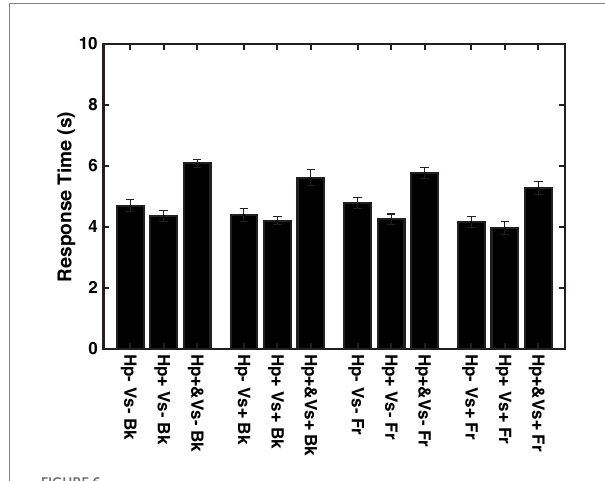
FIGURE 6 Response times for individual conditions. Vs +: visual cue present with binocular stereopsis. Vs -: visual cue absent with monocular presentation. Hp+&: haptic cue with visual presentation. Hp+: haptic cue subsequently to visual presentation. Hp − : no haptic cue. Fr: virtual ribbon in front of the word. Bk: virtual ribbon as a hollow in the word in the